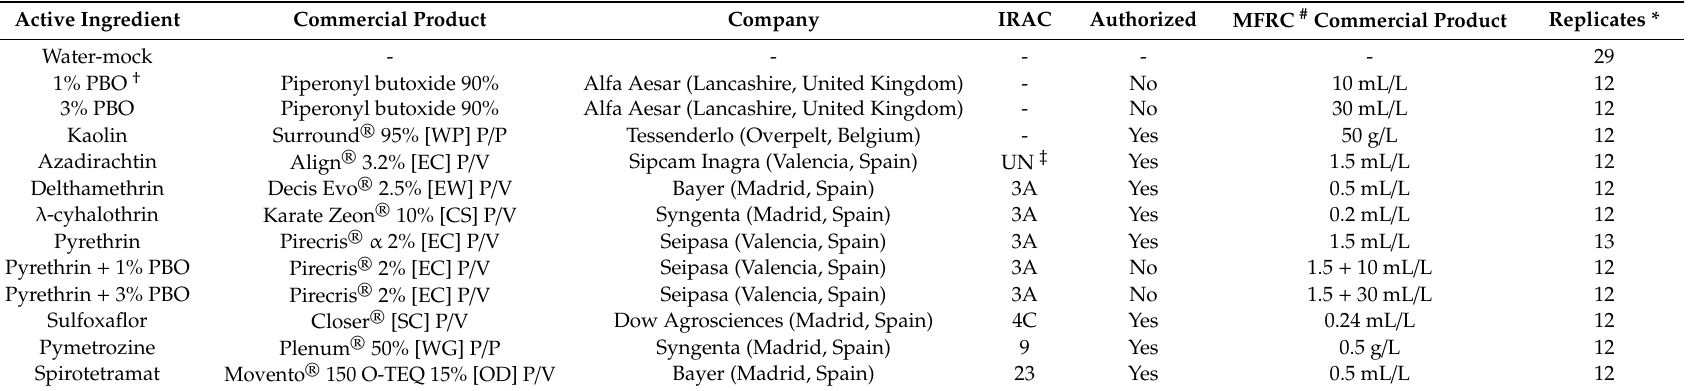
† PBO: piperonyl butoxide, ‡ UN: unknown, # MFRC: maximum field recommended concentration, * number variable depending on nymph availability (insects collected in the field), α exceptionally authorised in Spain in 2018 for the control of vectors of X.